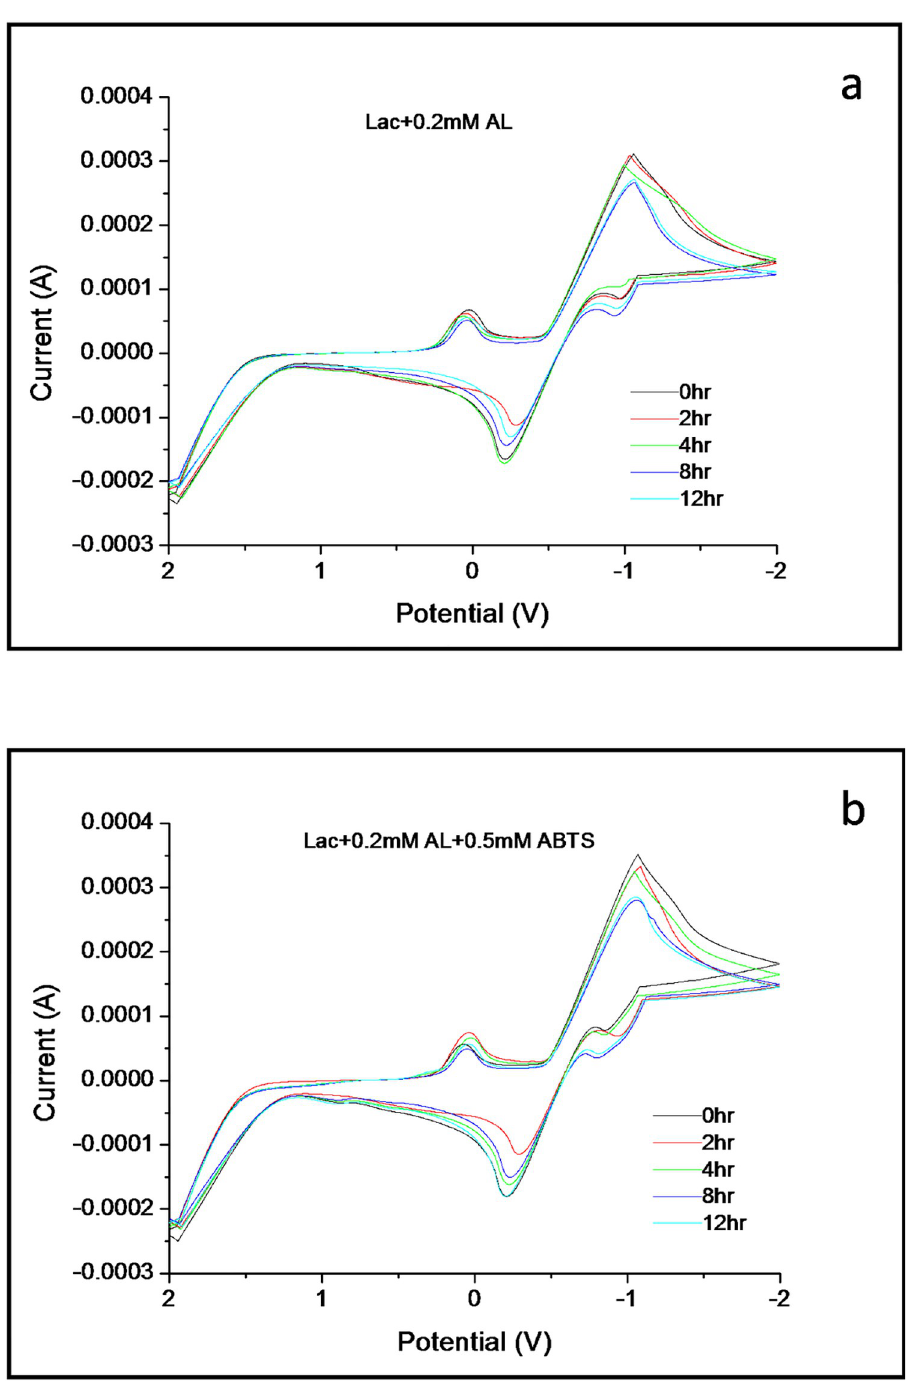
Fig 4. Cyclic voltammograms of AL (0.2mM) with Trametes versicolor laccase and the mediator ABTS (0.5mM) over 12 hours recorded in a buffered solution of pH 5 at a scan rate of